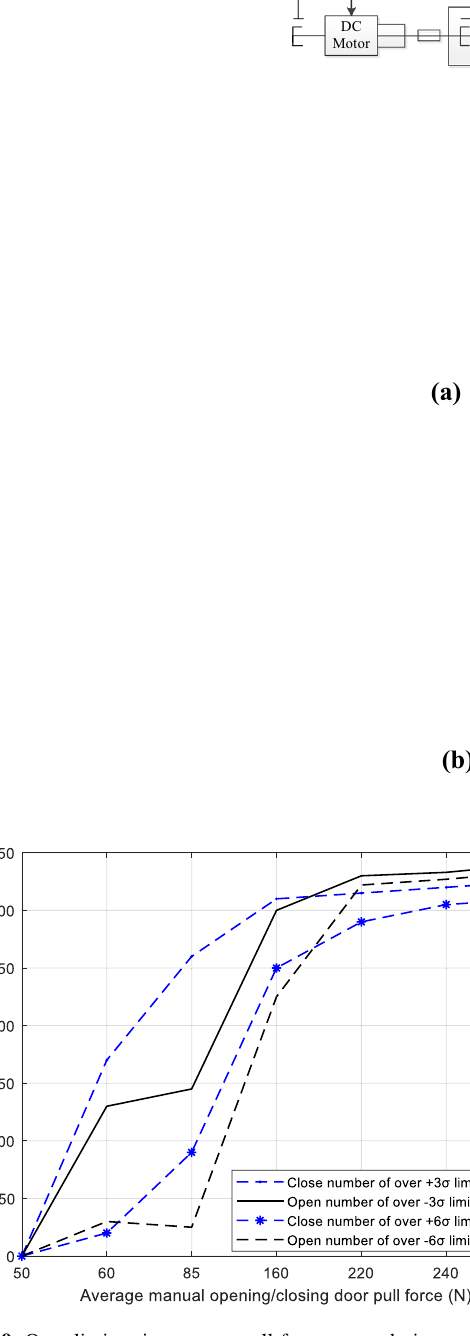
Fig. 9 Over-limit points versus pull force curve during manual door opening and closing